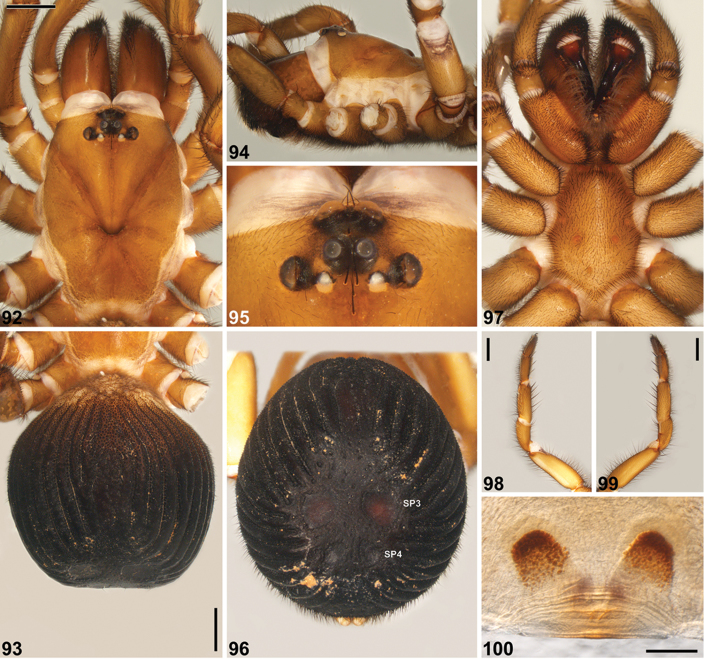

Idiosoma
clypeatum sp. n., female (WAM T108516) from Karara (Western Australia; YAL). 92–93 Carapace and abdomen, dorsal view 94 Carapace, lateral view 95 Eyes, dorsal view 96 Abdomen, posterior view 97 Sternum, ventral view 98 Leg I, prolateral view 99 Leg I, retrolateral view 100 Spermathecae, dorsal view. Scale bars 2.0 (92–93, 98–99), 0.5 (100). SP3–4 = sigilla pairs 3–4.